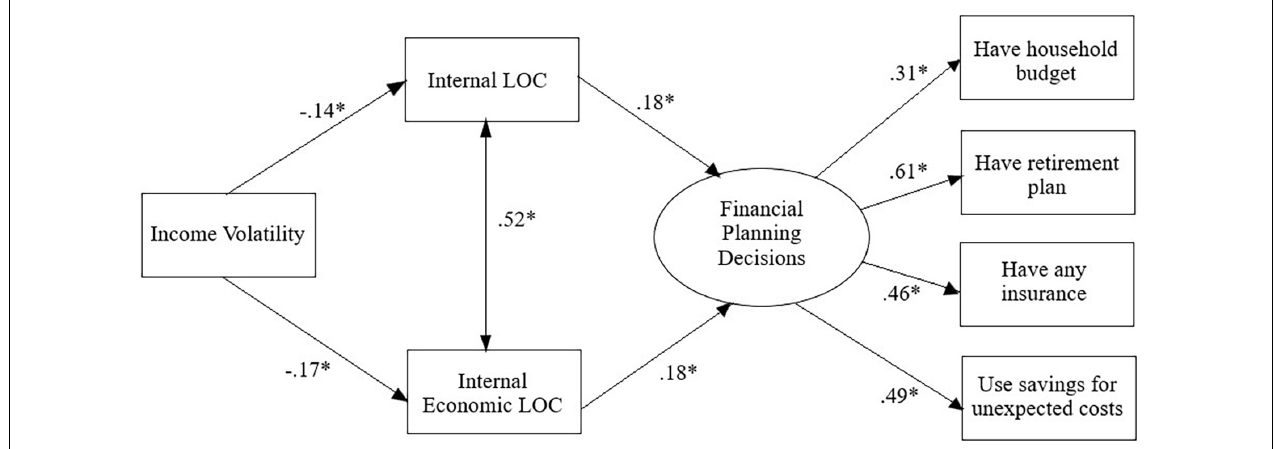
FIGURE 1 | Model presenting standardized coefficients. For ease of presentation, the covariates (age, gender, income, education) and error variances are not depicted, although they were included in the model. * p < 0.01. LOC = Locus of Control.